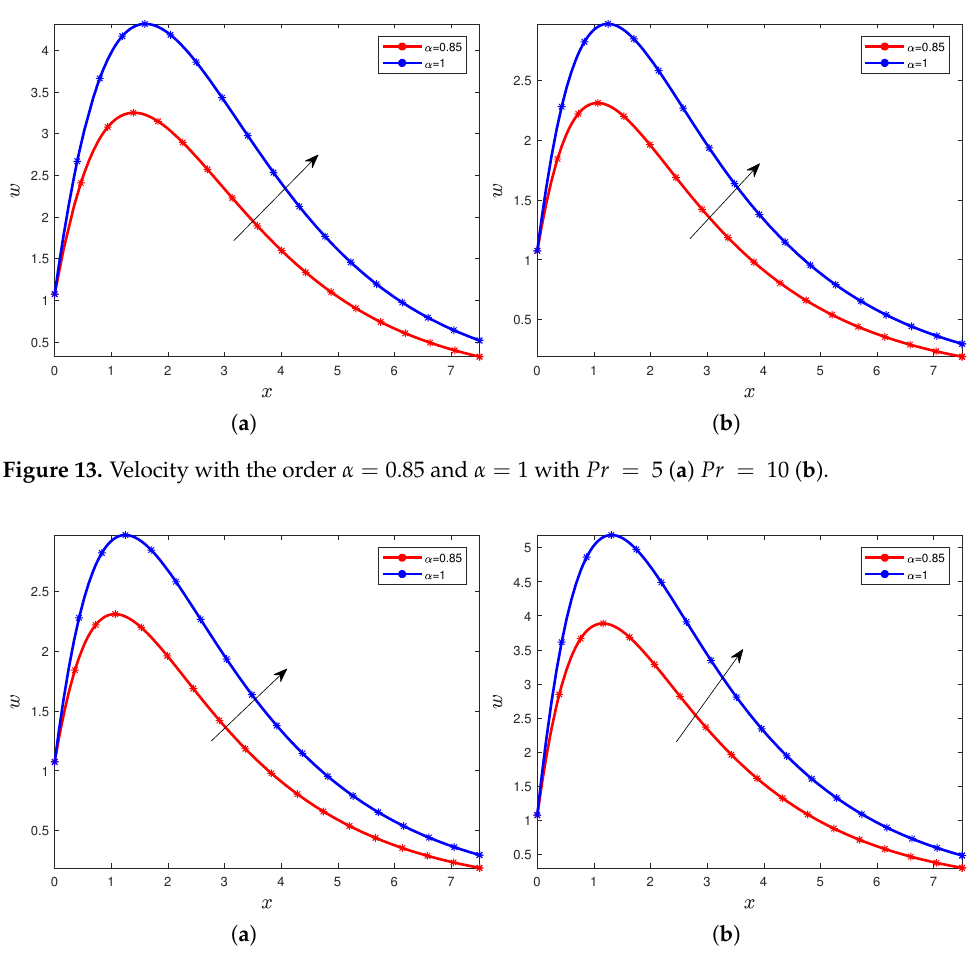
Figure 14. Velocity with the order α = 0.85 and α = 1 with Gr = 5 ( a ) Gr = 10 ( b